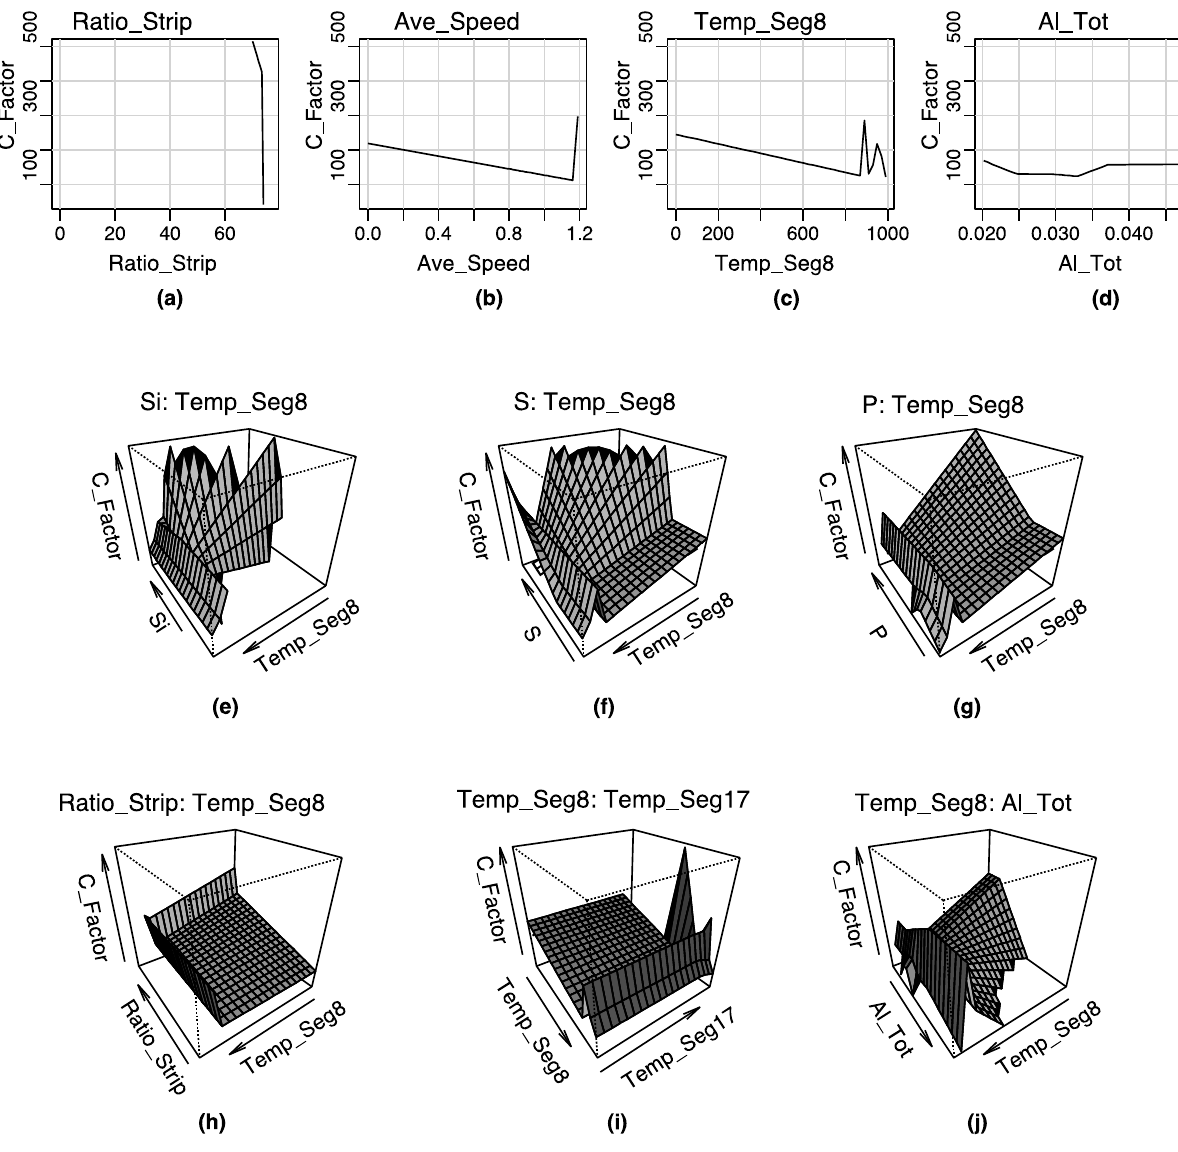
Figure 5. Graphical representation of the terms composing the MARS model for the C factor: ( a ) first order term of the predictor variable Ratio_Strip; ( b ) first order term of the predictor variable Ave_Speed; ( c ) first order term of the predictor variable Temp_Seg8; ( d ) first order term of the predictor variable Aluminum content; ( e ) second order term of the variables Si content and Temp_Seg8; ( f ) second order term of the variables Sulfur contents and Temp_Seg8; ( g ) second order term of the variables P content and Temp_Seg8; ( h ) second order term of the variables Ratio_Strip and Temp_Seg8 value; ( i ) second order term of the variables Temp_Seg8 and Temp_Seg17; ( j ) second order term of the variables Temp_Seg8 and Aluminum